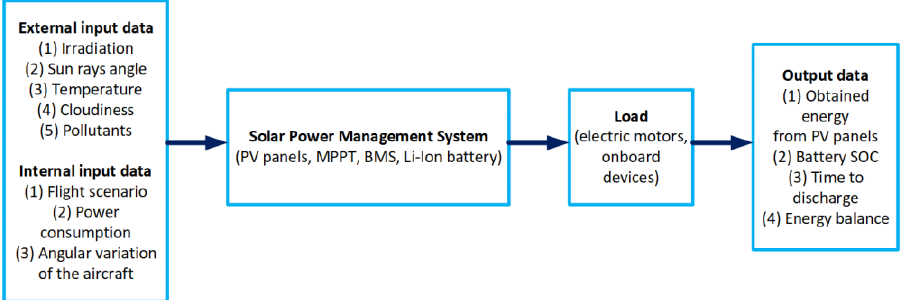
Figure 6. The process of defining parameters in the simulation model.